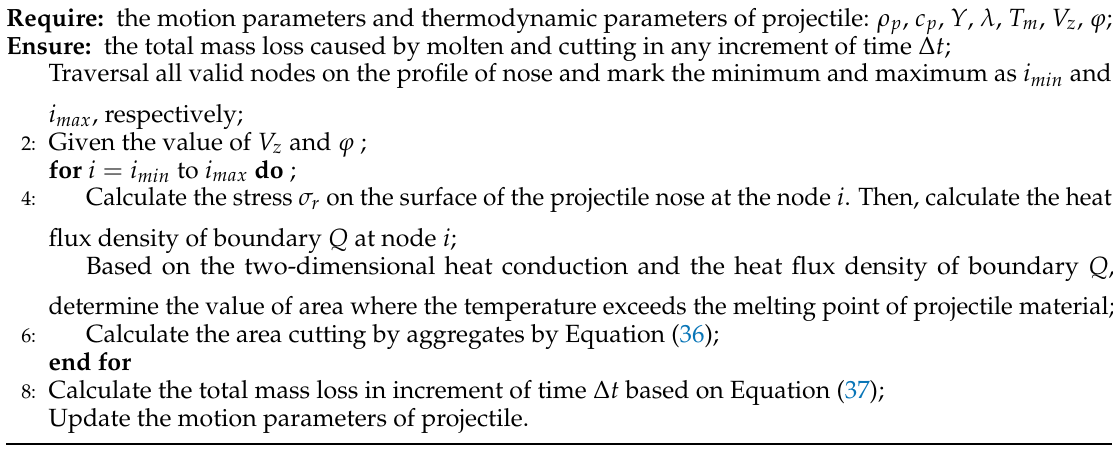
Algorithm 2 Calculation of mass loss in any increment of time ∆ t